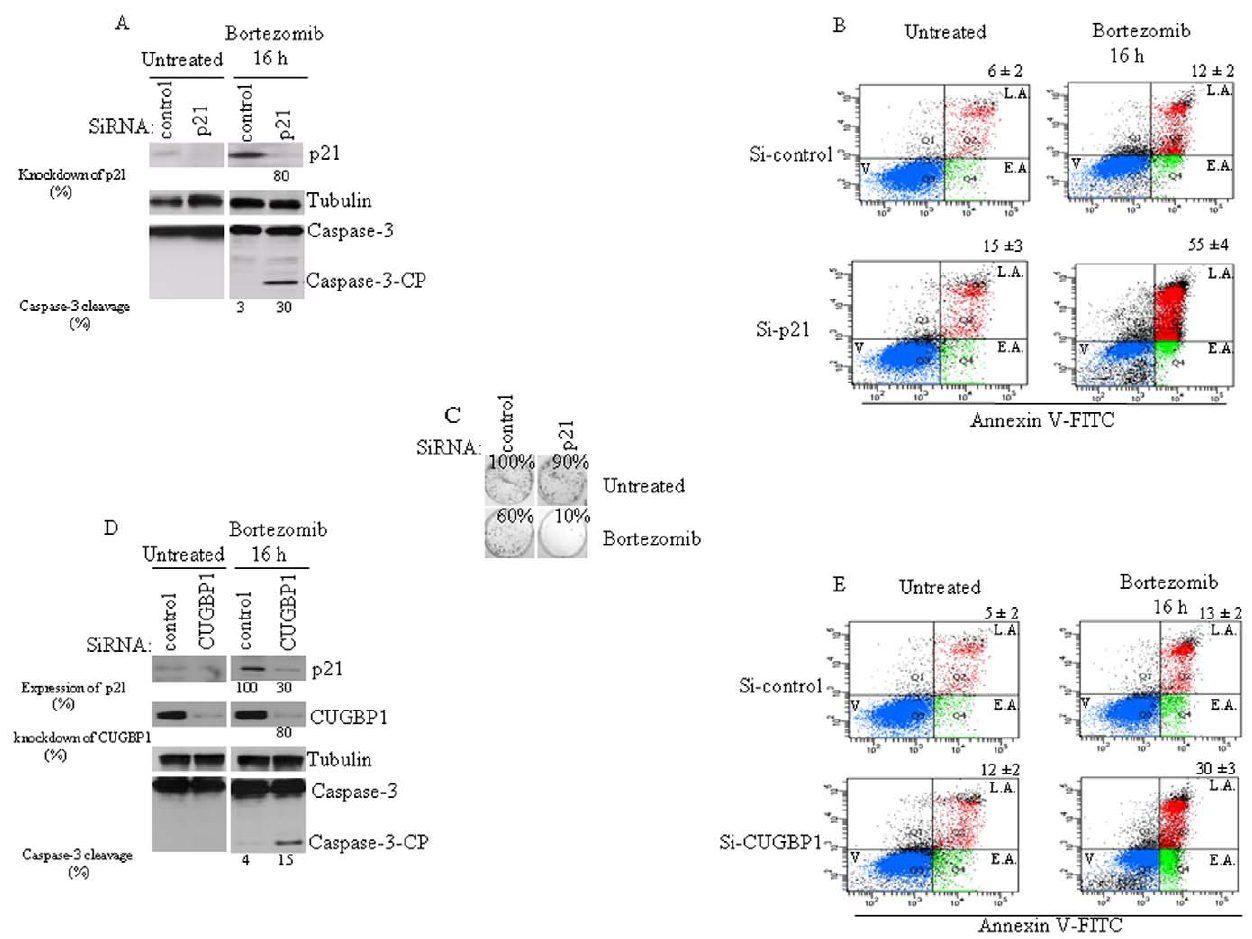
Figure 5. p21 depletion promotes bortezomib-mediated apoptosis. (A) HeLa cells were transfected with p21-directed siRNA, or with a control siRNA. Forty-eight hours later, cells were collected and their protein extracts analyzed by western blot for the amount of p21 ( top panel) using anti-p21 antibodies. The activation of caspase-3 was analyzed using anti-caspase-3 antibodies ( bottom panel). CP: cleaved product. Tubulin is used as a loading standard ( middle panel). The amount of p21 was determined by quantitation of the signals on films by densitometry using Adobe Photoshop software and expressed as a percentage relative to the amounts of tubulin. The percentage of caspase-3 cleavage was calculated by quantifying the signal of the caspase-3 cleaved product relative to the amount of total caspase-3. Shown are representative results of three different experiments. (B) Following treatment with p21-specific siRNA or with a non-specific siRNA, HeLa cells were incubated with bortezomib for 16 h, then stained with annexin V-FITC and PI, and analyzed by flow cytometry. The percentage of total dead or dying cells (indicated at the top of each panel) was defined as the sum of early ( lower right box) and late ( upper right box) apoptosis and corresponds to the mean 6 SEM from three independent experiments. V: viable cells; E.A: early apoptosis; L.A: late apoptosis. (C) Clonogenic assays. Following treatment with p21-specific siRNA or with a non- targeted siRNA, HeLa cells were incubated with bortezomib for 16 h, trypsinized, counted, replated in the absence of drug, and incubated for 10 d. Prior to counting colonies, cells were fixed, and then dried. Populations . 50 cells were counted as one surviving colony. Data were calculated as the percentage of surviving colonies relative to the number found in control (untreated) plates. Results are expressed as the mean of triplicate measurements. (D–E) Reducing CUGBP1 levels promotes bortezomib-induced apoptosis . HeLa cells were treated with CUGBP1-specific siRNA, or